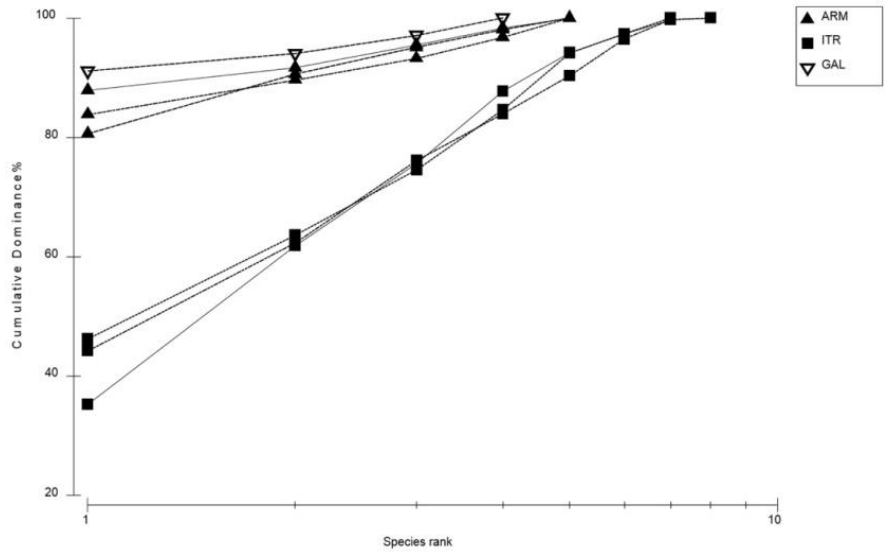
Figure 8. K-dominance curves for rhodolith species abundances (in terms of cover percentages) in the different sites of the three study areas (ARM: Armeleia shoal; ITR: Tremiti Islands; GAL: Gallipoli).